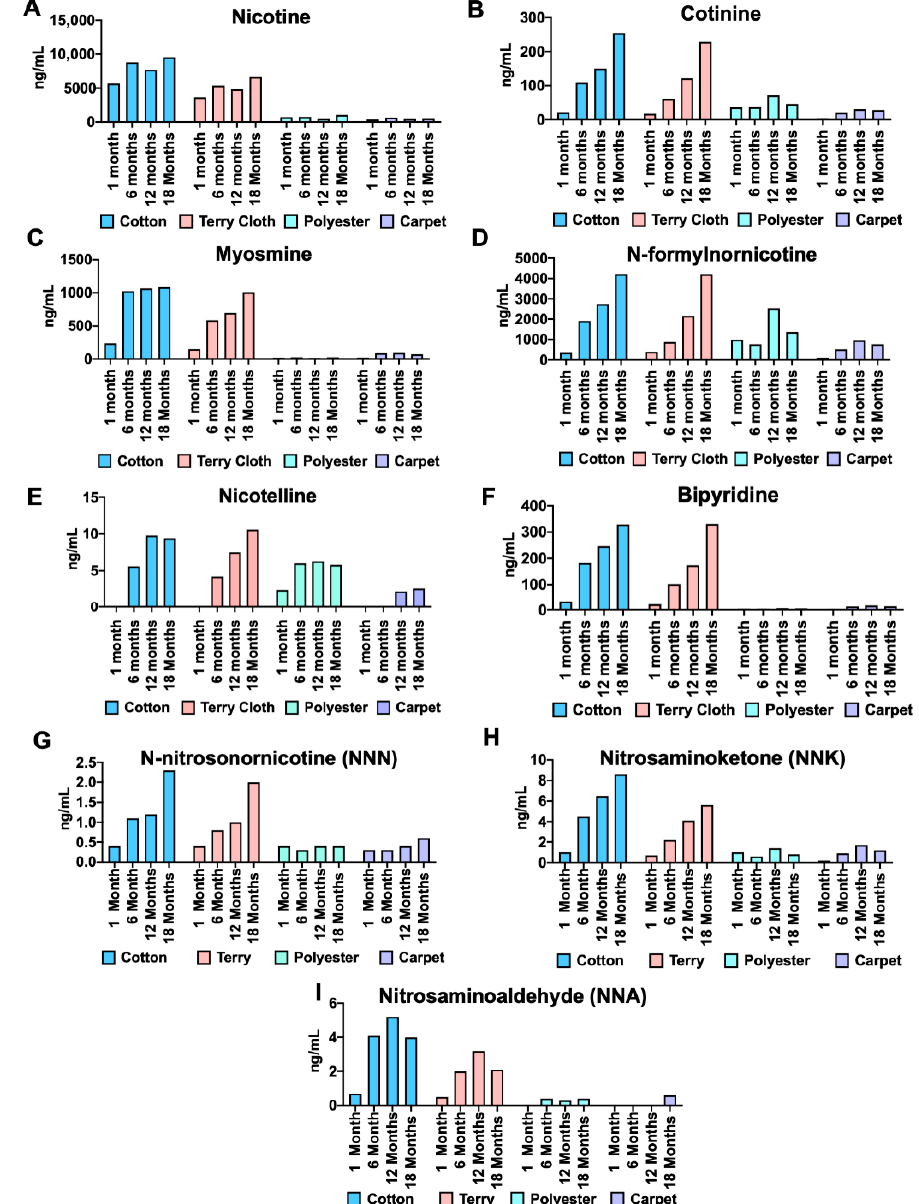
Figure 4. Concentrations of various chemicals in THS extracts of cotton, terry cloth, polyester, and wool carpet measured using HPLC. ( A – I ) Nicotine, nicotine alkaloids, and TSNA concentrations were higher in THS extracts from cotton and terry cloth compared to polyester and wool carpet.